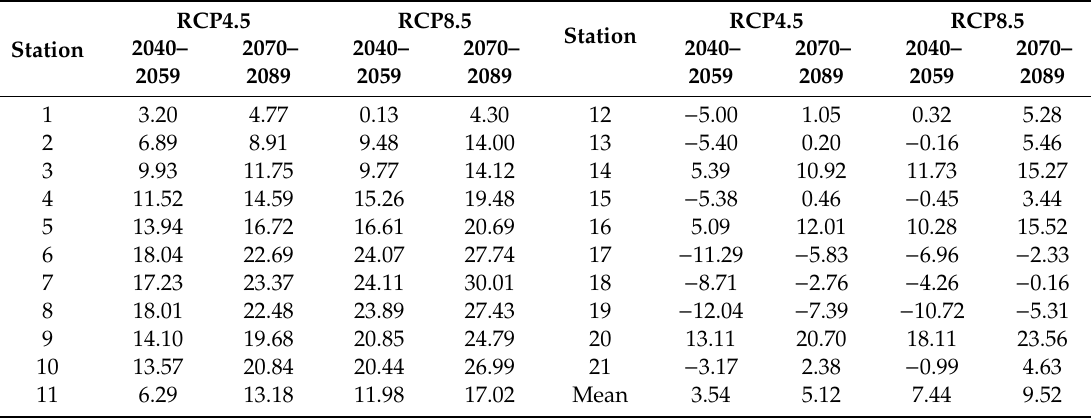
Table 10. Changes (%) of precipitation in the future compared with the baseline year.